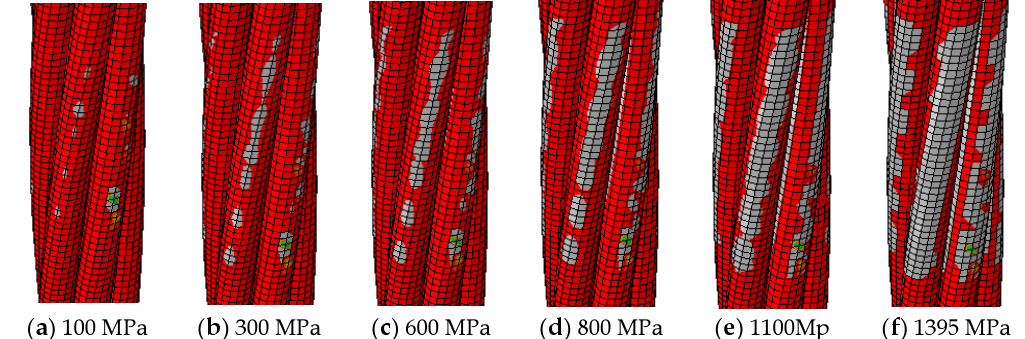
Figure 7. Contact area of the surface of the steel strand (gray surface).